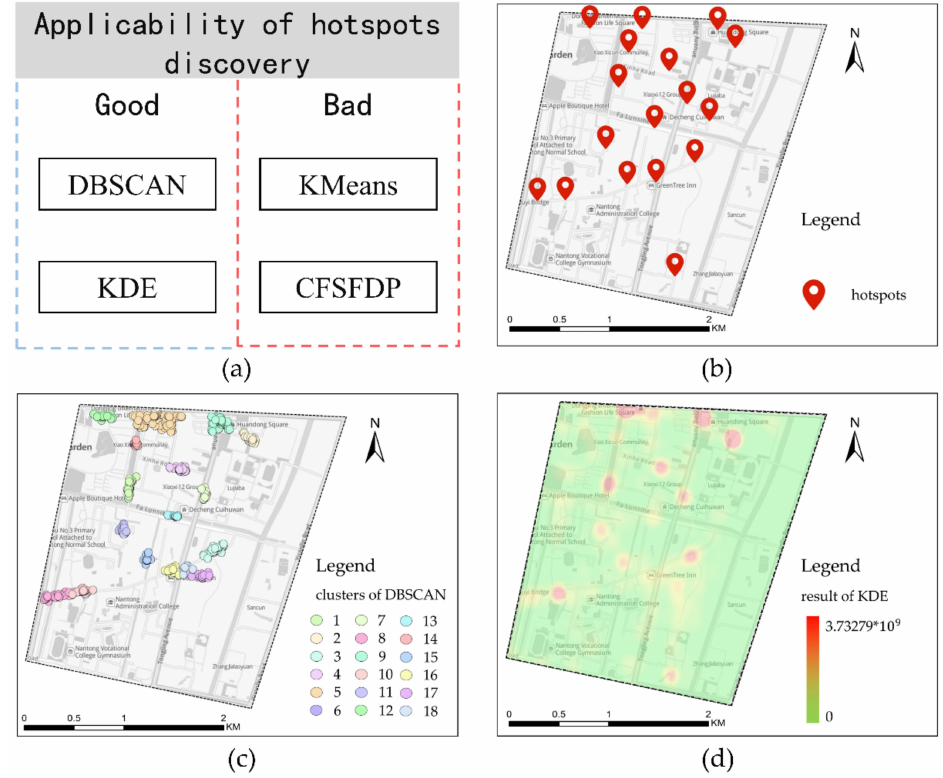
Figure 4. Clustering results of the hotspots discovery: ( a ) Application of hotspots discovery; ( b ) Distribution of hotspots; ( c ) The results of DBSCAN; ( d ) The results of KDE.